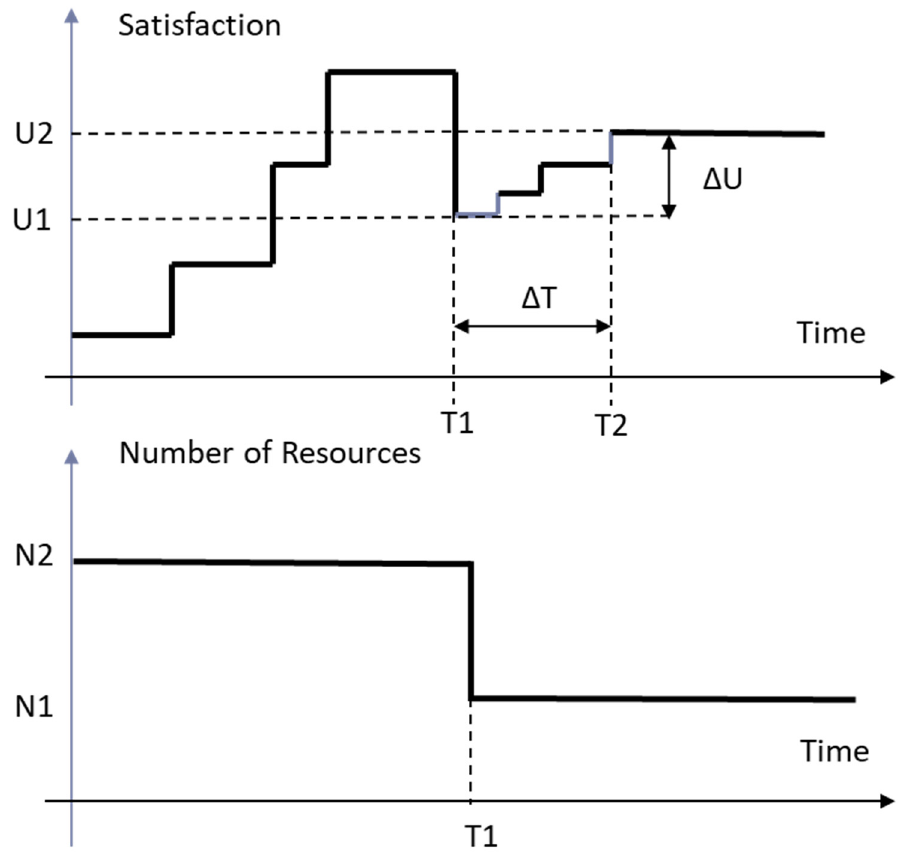
Figure 13. Adaptation by EI in case of an unpredictable, disruptive event.